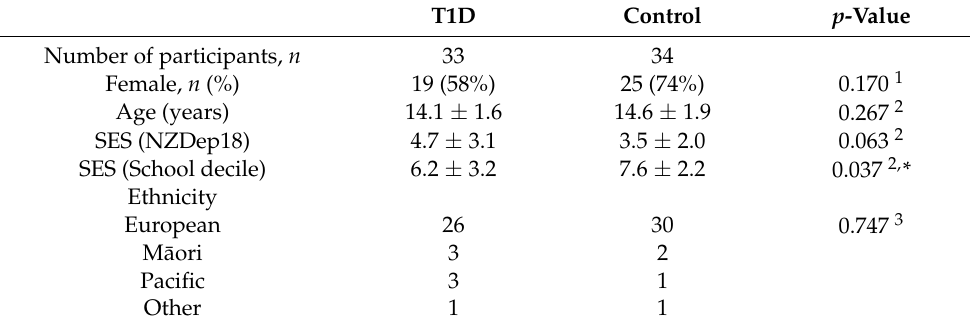
Table 1. Participant demographics.